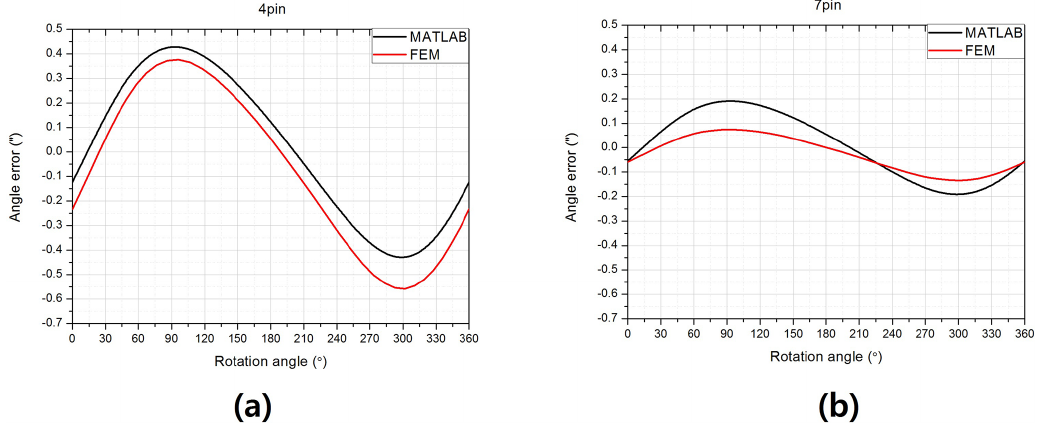
Figure 10. Comparison of the equation and the